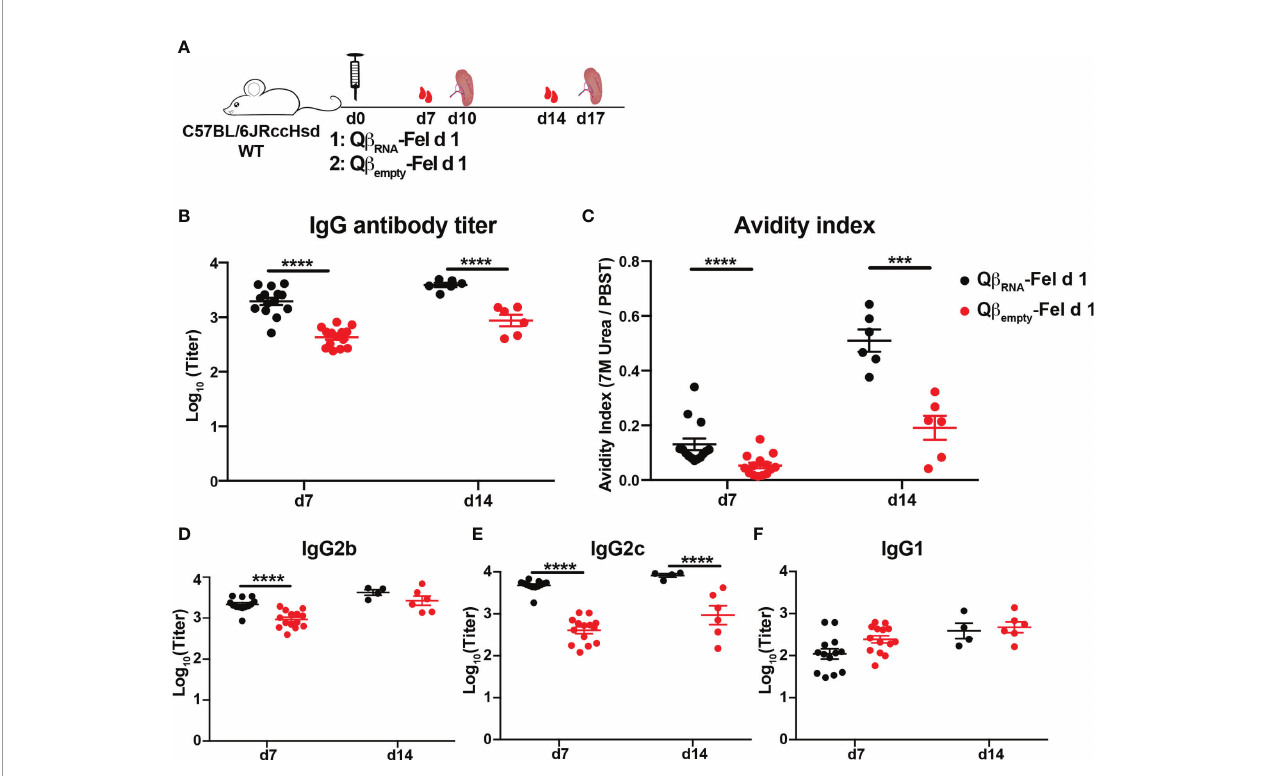
FIGURE 3 | Fel d 1-speci fi c antibody responses of WT mice upon Q b RNA -Fel d 1 or Q b empty -Fel d 1 immunization. (A) Immunization scheme. Fourteen mice were immunized with 30 m g Q b RNA -Fel d 1 or Q b empty -Fel d 1 at d0 and were bled at d7. Eight mice were euthanized to harvest spleen and sort Fel d 1-speci fi c B cells at d10, so 6 mice were bled at d14 and euthanized for Fel d 1-speci fi c B cells sorting at d17. Fel d 1-speci fi c antibody titers (B) , avidity indexes (C) , and IgG2b (D) , IgG2c (E) and IgG1 (F) subclasses generated by WT mice after immunization were determined by ELISA. p value from unpaired t-test was indicated as ≤ 0.001 (***), ≤ 0.0001 (****). The fi gure is based on one